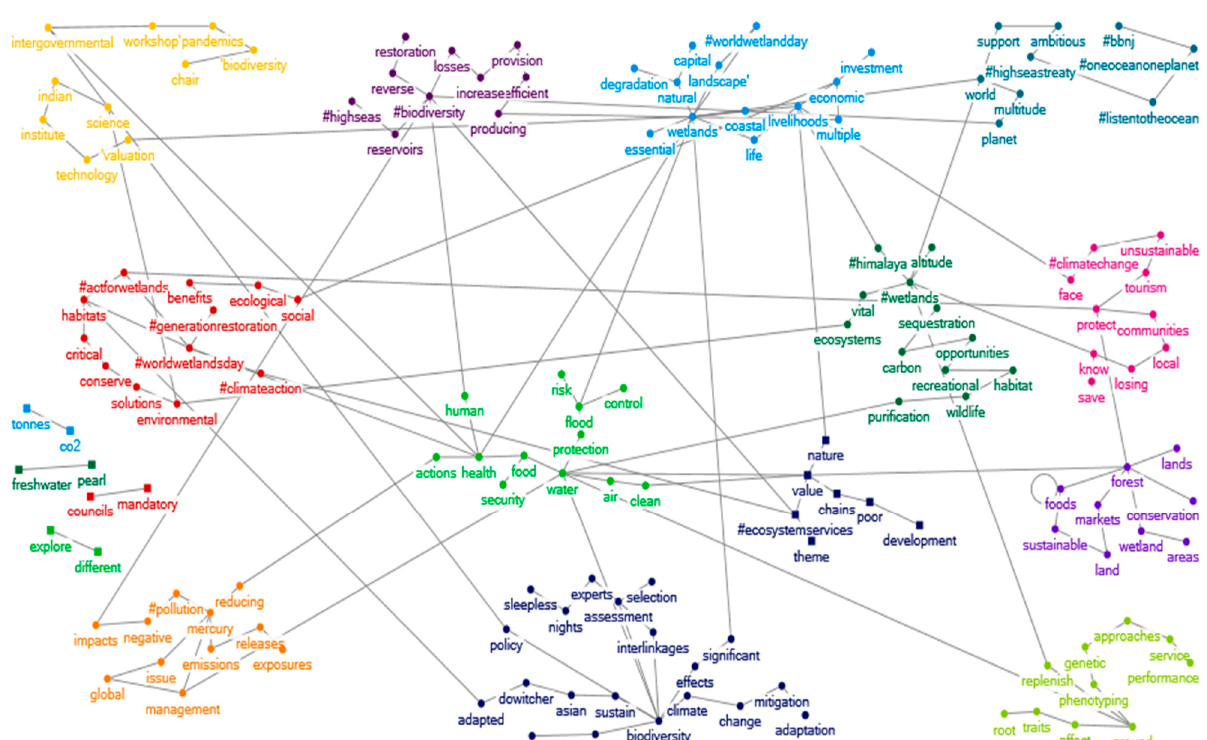
Figure 6. Semantic networks on tweets about ecosystem services (3 February 2022). The different colours represent the different clusters.